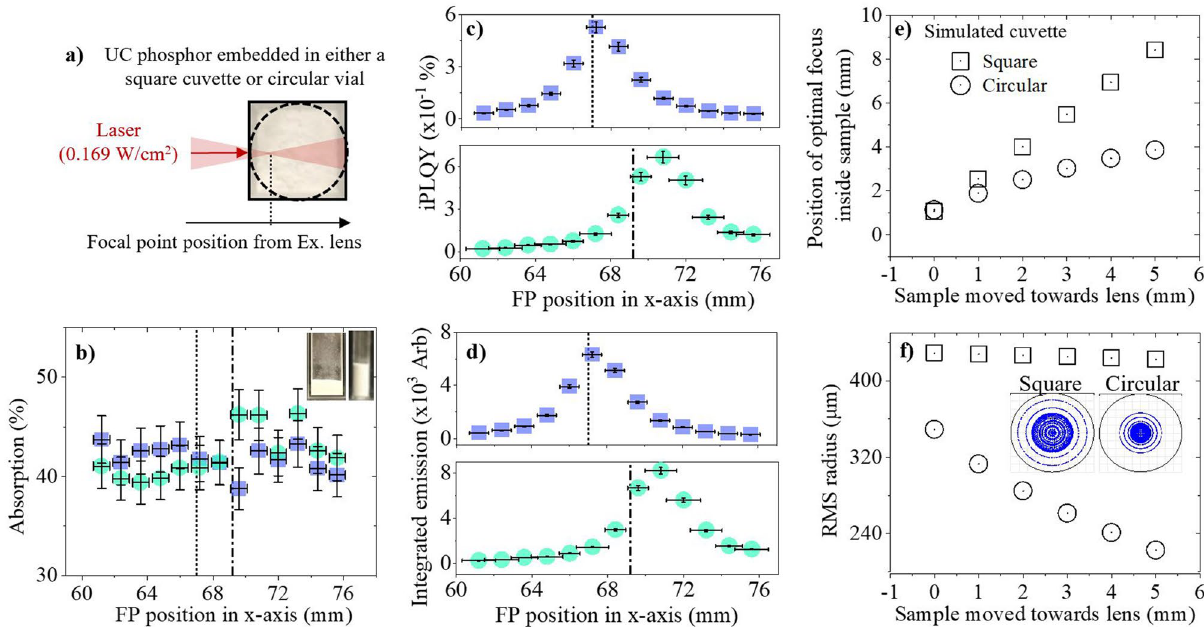
Figure 6. β-NaYF 4 :(18%)Yb 3+ ,(2%)Er 3+ phosphor is embedded in either a cuboid cuvette (blue square) or a cylindrical vial (light blue circle), and excited using a 980 nm laser diode, as shown in ( a ). The following is presented against the lasers excitation FP positions: ( b ) absorption, ( c ) iPLQY (500–700 nm), with inset images of the cuboid and cylindrical containers used, and ( d ) integrated emission (500–700 nm). The second investigation simulates square and circular containers moving towards the excitation lens to represent different FP penetration depths through the sample. The following is measured against sample position: ( e ) position of optimal focus inside container, and ( f ) RMS radius, with an inset image of the simulated beam FP in a square cuvette (left) and circular vial (right) when each sample is at its closest simulated position to the excitation